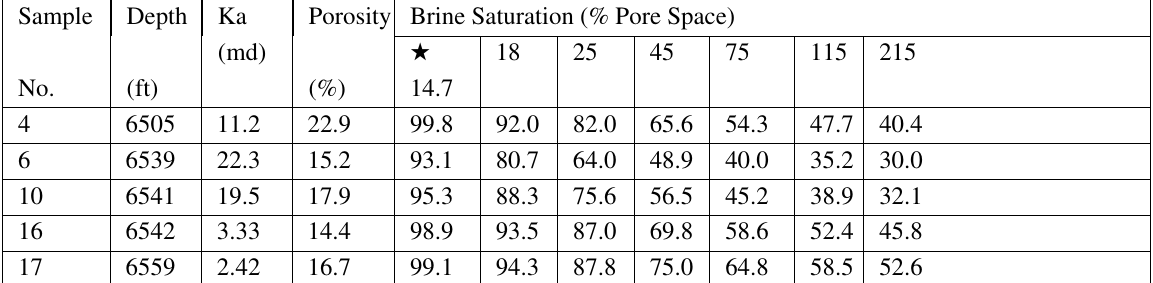
Table 3. Air-Brine capillary pressure data for Upper Bahariya